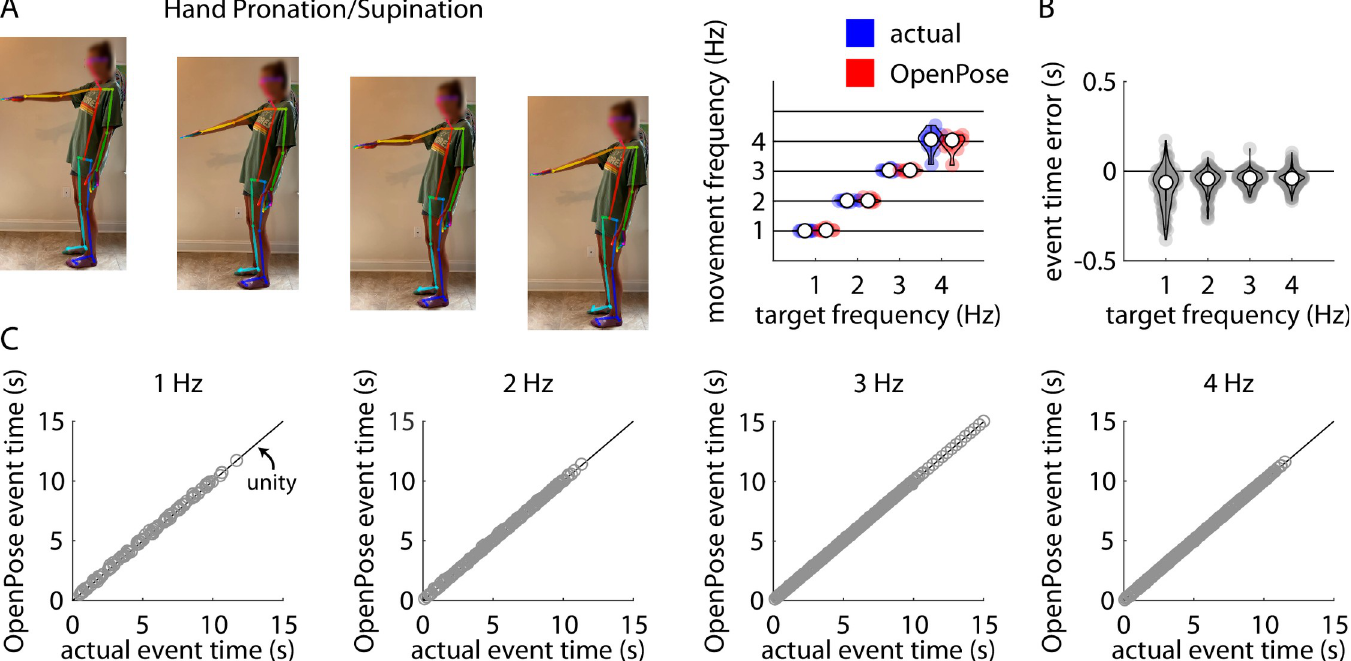
Fig 4. A) Representative example of stillframes from an OpenPose output video of a participant performing the hand pronation/supination task (left) and violin plots showing comparisons of individual participant mean hand pronation/supination frequencies measured manually (“actual”, blue) and using our pose estimation workflow (“OpenPose”, red) across all four target frequencies (right). B) Violin plots showing event time errors (i.e., differences between video timestamps of hand pronation or supination events as measured manually and using pose estimation) for each individual hand pronation or supination event across all participants. C) Scatter plots showing relationships between the video timestamps of all individual hand pronation or supination events across all participants as measured manually (x-axis) or using our pose estimation workflow (y-axis) across all four target